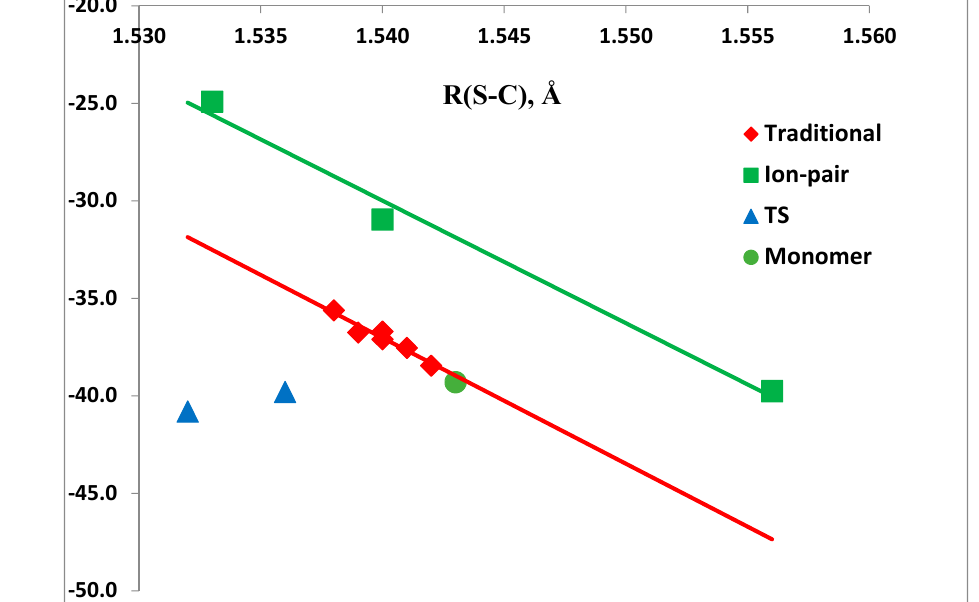
Figure 8. 1 J(S–C) versus the S–C distance for SC:ClY complexes, transition structures, and ion pairs, and the CS monomer.